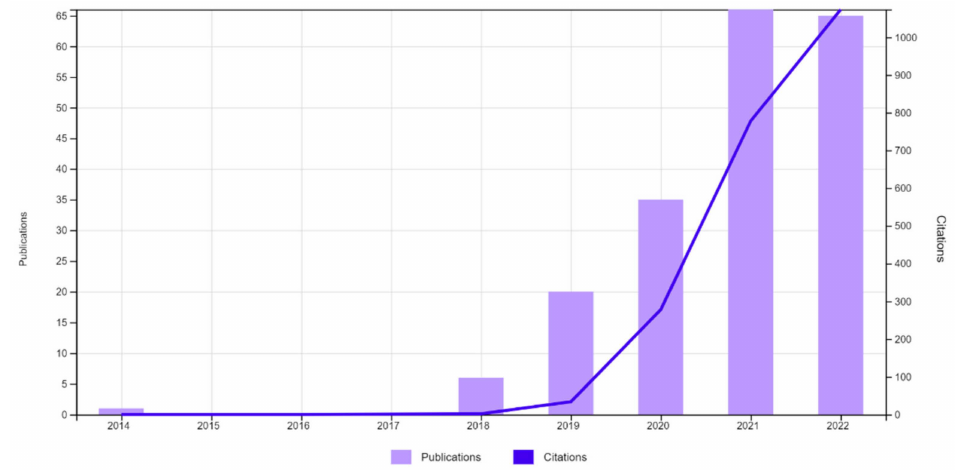
Figure 2. Number of publications and citations